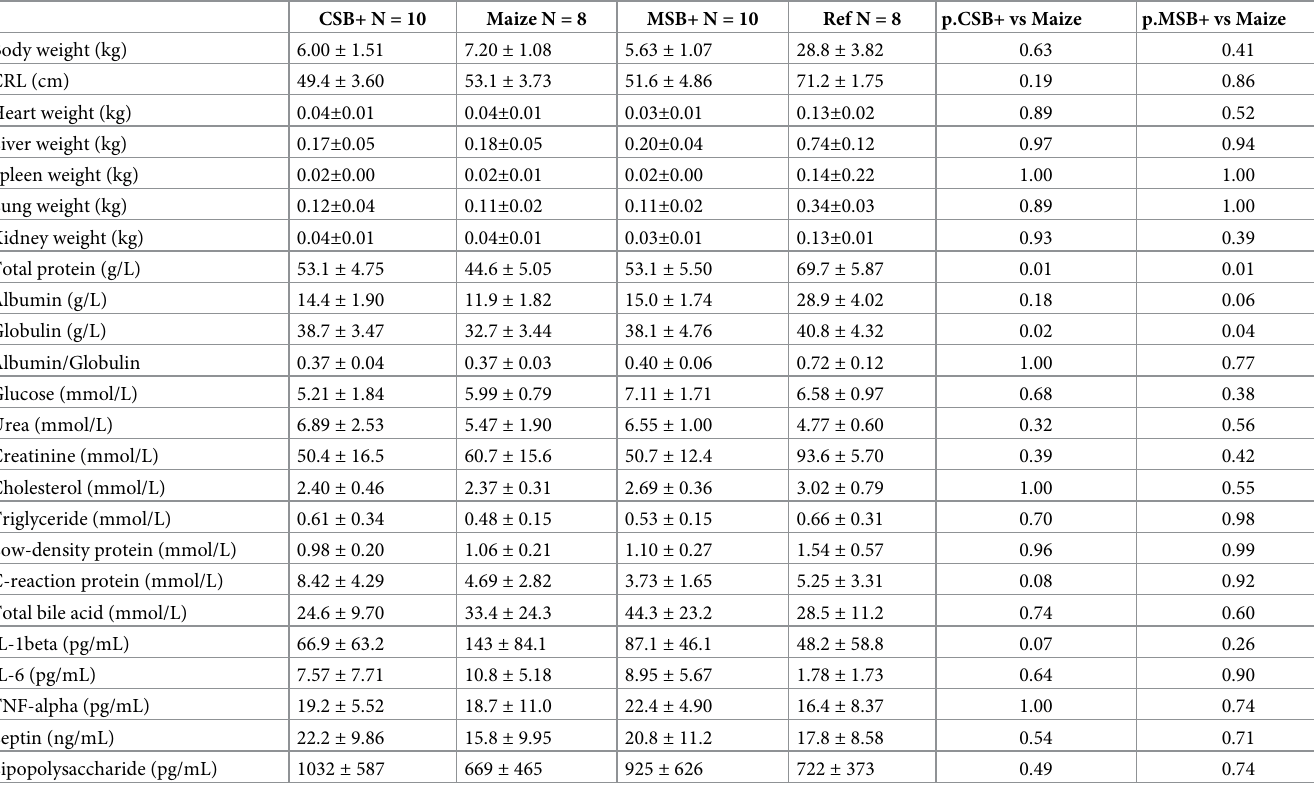
Table 2. Pig growth, blood biochemical and systemic immune index.